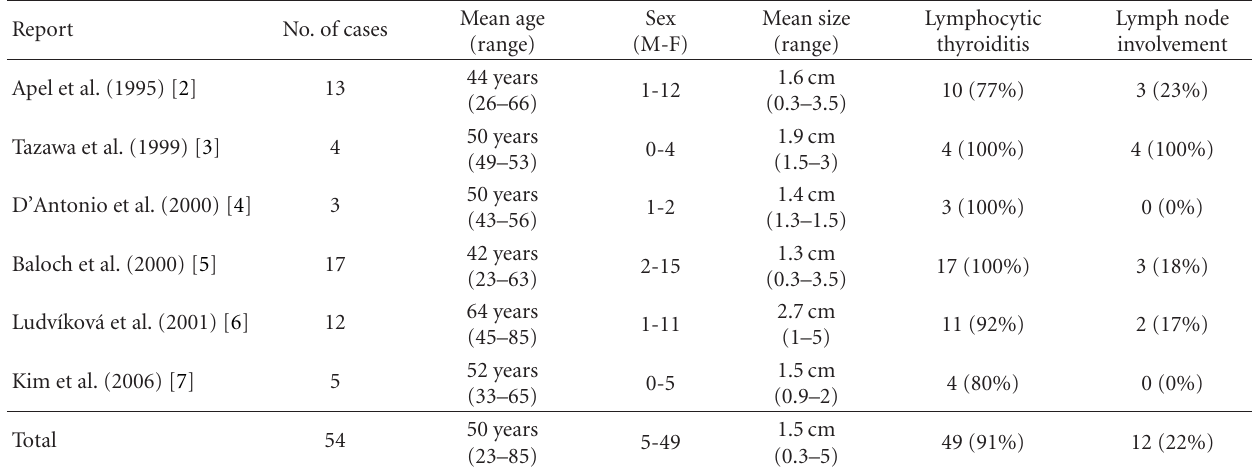
Table 1: Demographic and clinical data of patients with WaLPTT as depicted in the literature.